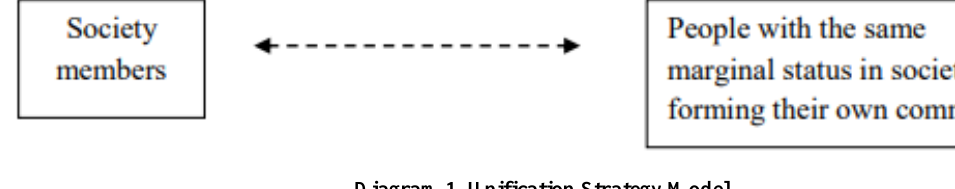
Diagram 1. Unification Strategy Model